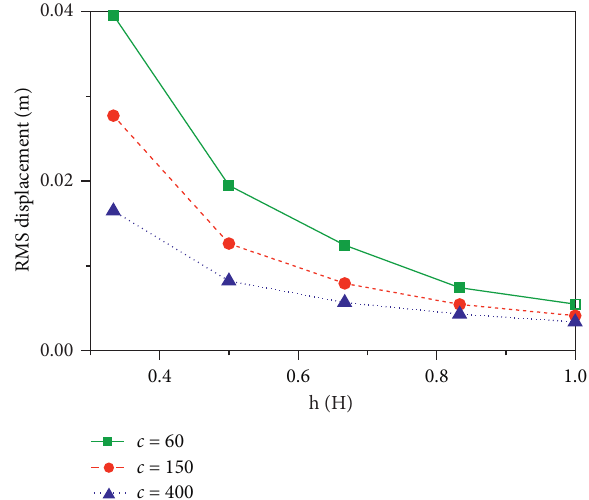
Figure 12: The relationship between the root mean square of structural displacement response and the installation height of damping cable h / H